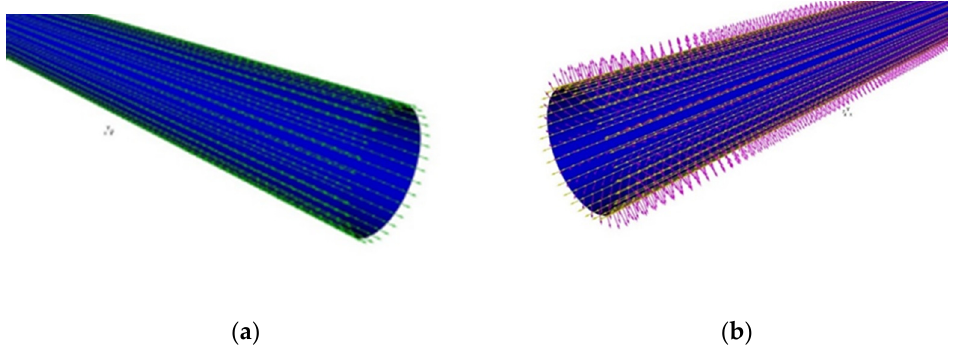
Figure 5. Definition of composite tensile armor. ( a ) Reference axis, ( b ) 0° fiber.